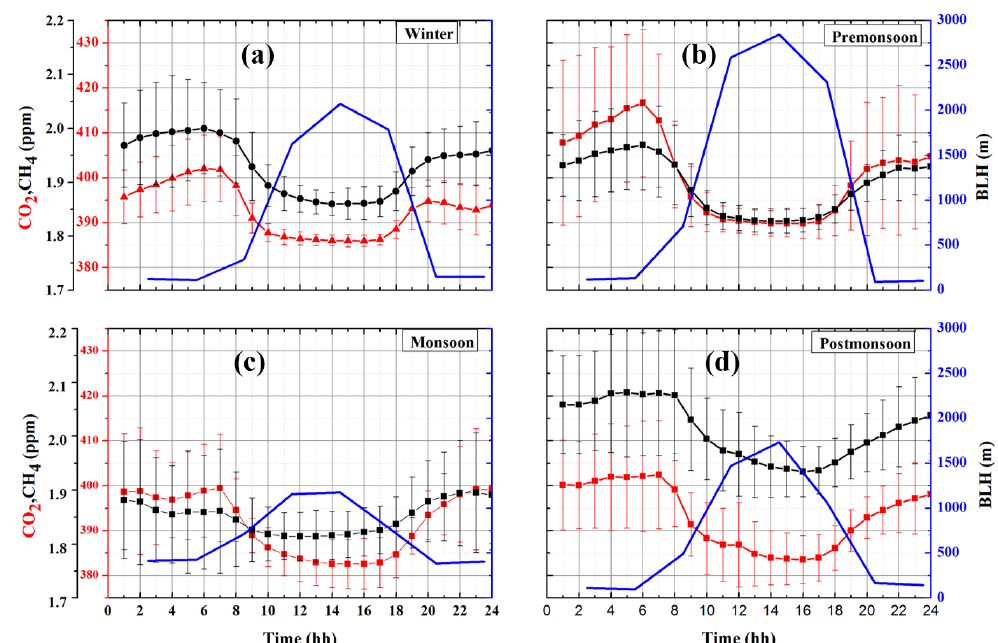
Figure 5. (a–d) Seasonal variations of diurnal averaged CO 2 / CH 4 against boundary layer height during